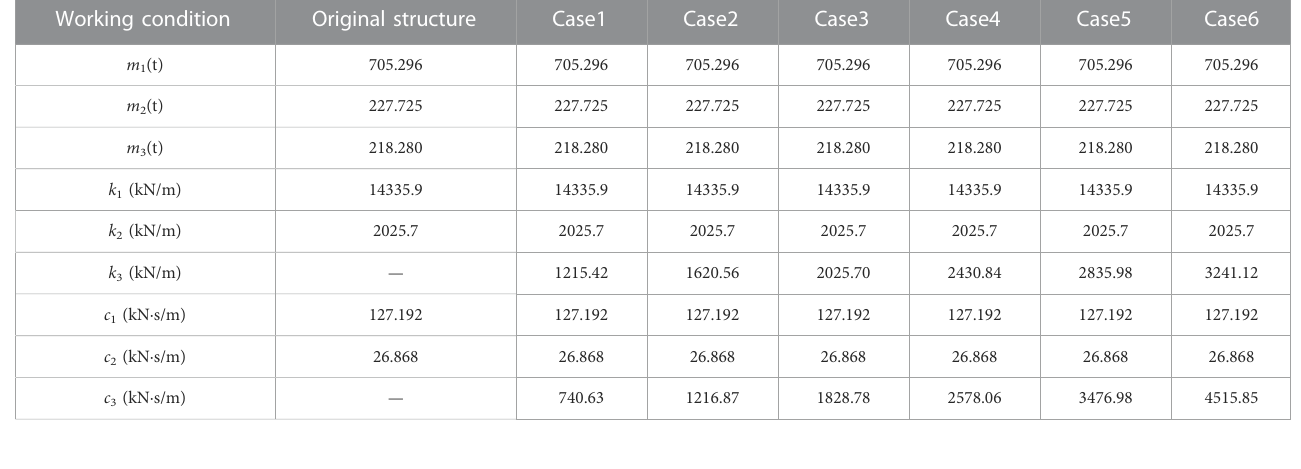
TABLE 4 The calculation parameters of damping vibration isolation system simpli fi ed model. Working condition